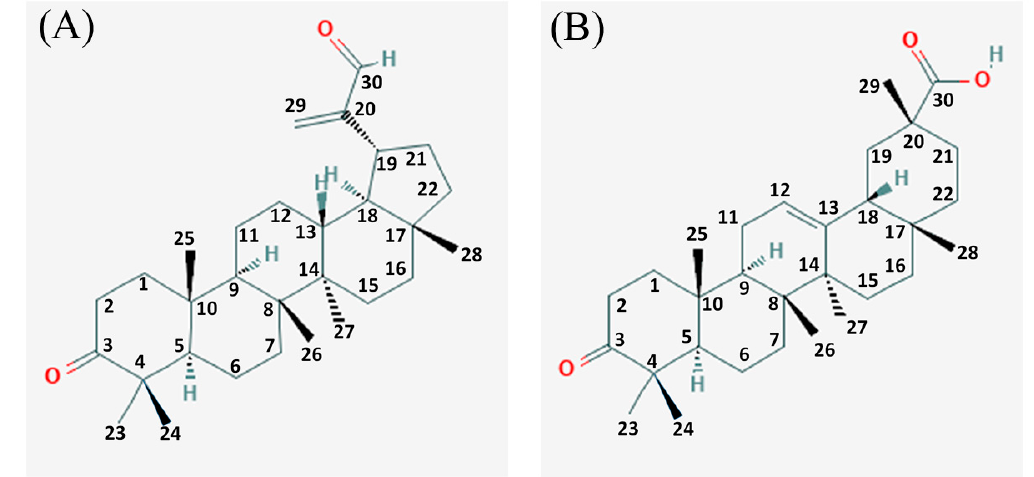
Figure 1. Structures of ( A ) 3-oxolupenal, and ( B ) katononic acid.